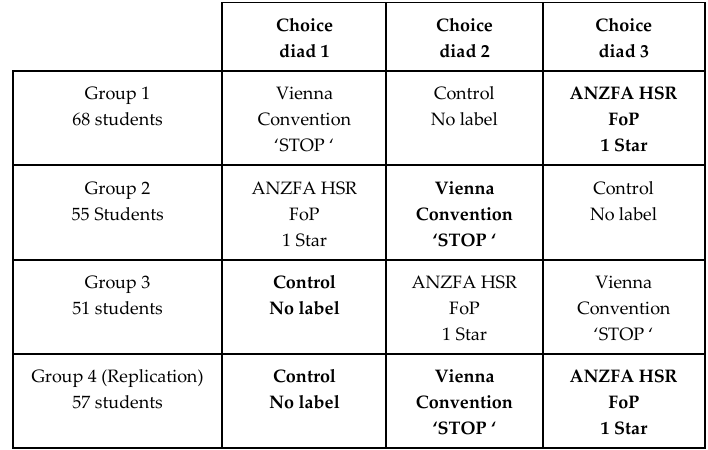
Figure 4. Experimental design: a 3 × 4 partially replicated Latin square by Youden and Hunter (1955) [55].